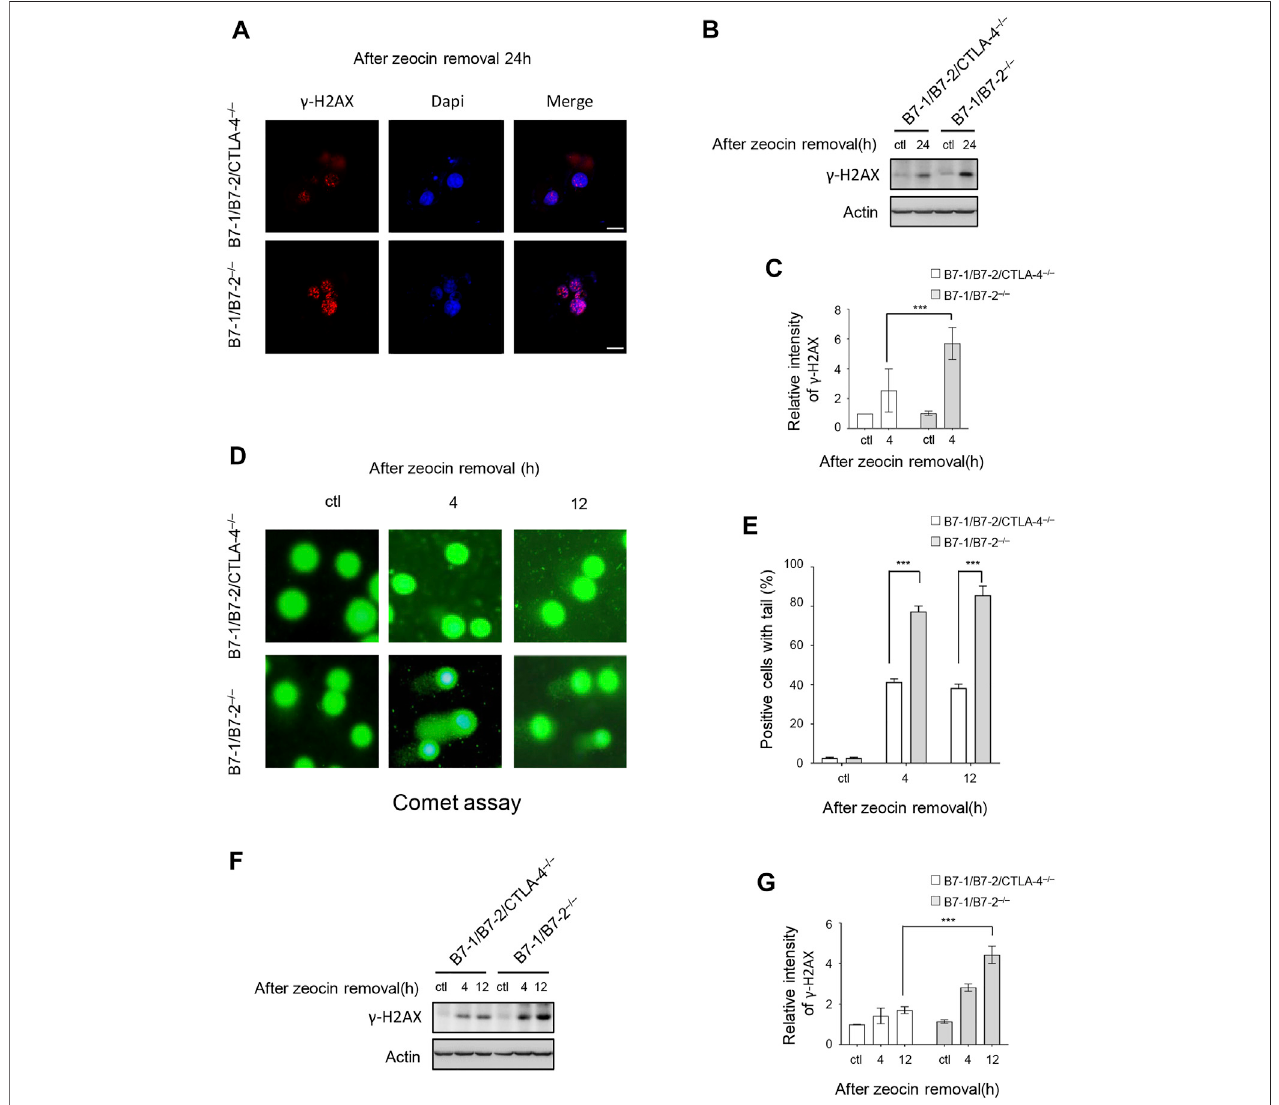
FIGURE 2 | Zeocin treatment causes overwhelming DNA damage in CTLA-4 – expressing cells. CD4 + T cells from B7-1/B7-2 − / − and B7-1/B7-2/CTLA-4 − / − mice were treated with 500 μ g/ml zeocin for 1 h and then released and harvested at the indicated times. (A) Representative bright fi eld and immuno fl uorescence images of γ H2AXintreatedTcells.Scalebar,10 μ m. (B) CellspreparedfortheassayshowninpanelAwereanalyzedfor γ H2AXlevelsusingwesternblotting. (C) Quanti fi cationof the γ H2AX immunoblot intensity. Each experiment was independently performed three times ( n = 3). (D) DNA damage was assessed using the comet assay. Representative images of cellular DNA damage are presented. (E) Histogram showing the percentage of T cells with tail DNA greater than 10%. Experiments were performedthreetimesindependently( n =3),andmorethan100cellspersamplewerecountedineachexperiment.Dataarepresentedasthemean±SEM;*** p < 0.001. (F) DNA damage was determined by measuring changes in the γ H2AX levels in the cells shown in panel C using western blotting. (G) Quanti fi cation of the γ H2AX band intensity in the corresponding groups. Each experiment was independently performed three times ( n =